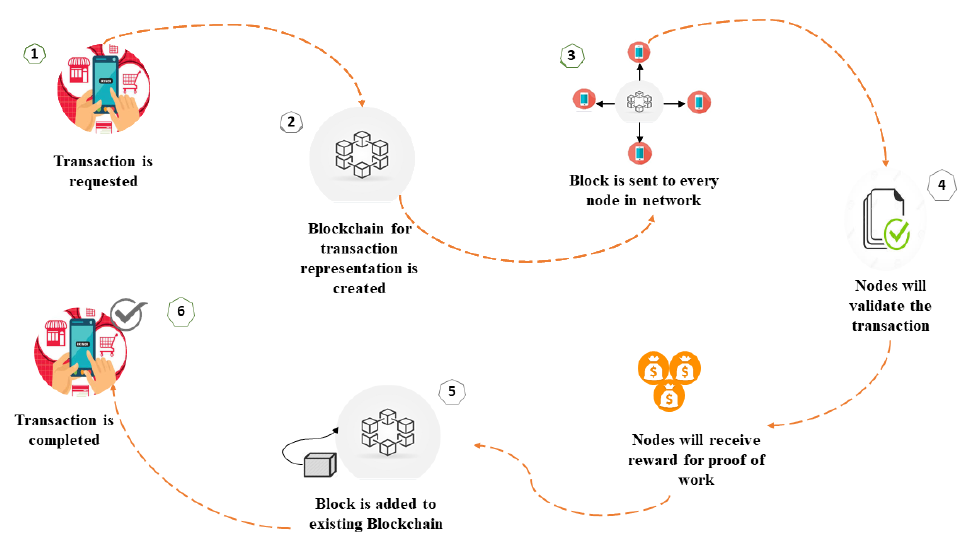
Figure 2. Blockchain transaction process. Ethereum Blockchain